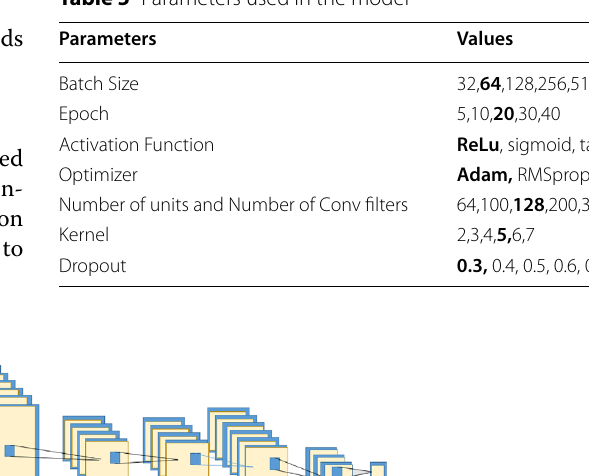
Table 5 Parameters used in the